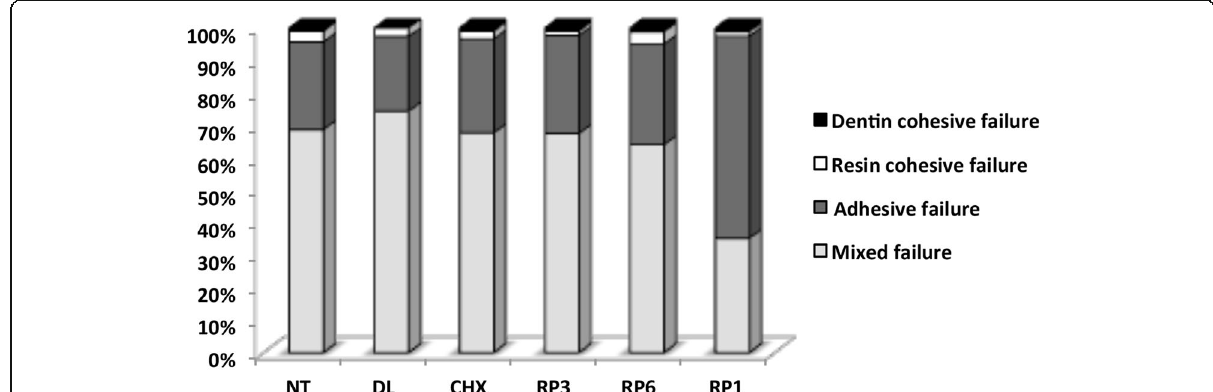
Fig. 4 Percentage of the type of fractures per group. The graph shows the predominance of mixed failures. RP1, 1% red propolis nanosuspension; RP6, 0.6% red propolis nanosuspension; RP3, 0.3% red propolis nanosuspension; CHX, 2% digluconate chlorhexidine; DL, placebo (micellar nanocomposites without ethyl acetate extract from Brazilian red propolis); NT, no treatment (negative